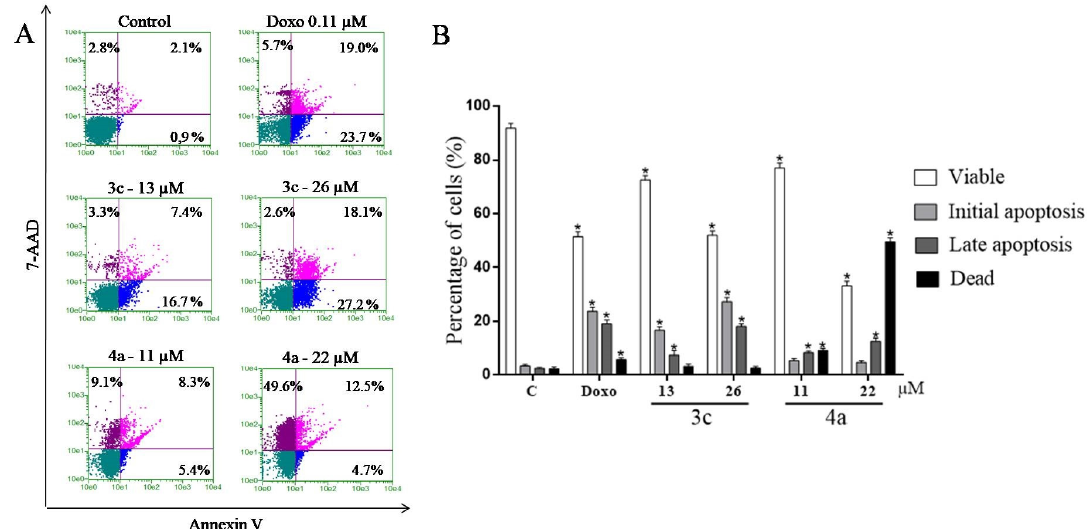
Figure 8. E ff ect of compounds 3c and 4a on the induction of death of HL-60 cells after 72 h of incubation. ( A ) Distribution of cells positive for Annexin V and / or 7-AAD is reported inside the quadrants. ( B ) The percentage of viable, apoptotic and dead cells. Doxorubicin (Doxo, 0.11 µ M) was used as standard. C = control, was treated with the vehicle (DMSO; 0.1%). Results are expressed as mean ± SD of at least three di ff erent experiments performed in triplicate. * p < 0.05 compared with the negative control by ANOVA followed by Student Newman-Keuls test.